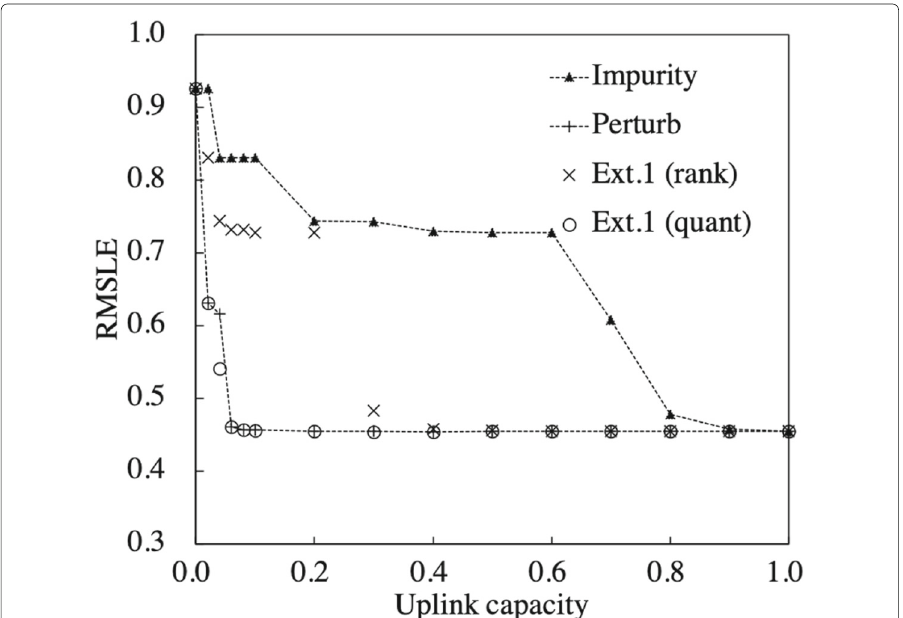
Fig. 9 Prediction accuracy (RMSLE) vs. uplink capacity obtained using RF for prediction. Perturb, impurity, or extension scheme 1 with ranking and quantizing was used for feature